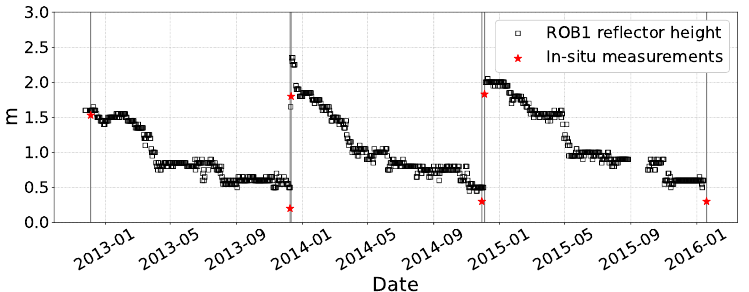
Figure 6. GNSS-IR daily reflector height for the ROB1 antenna. In situ measurements of the antenna height are reported as red